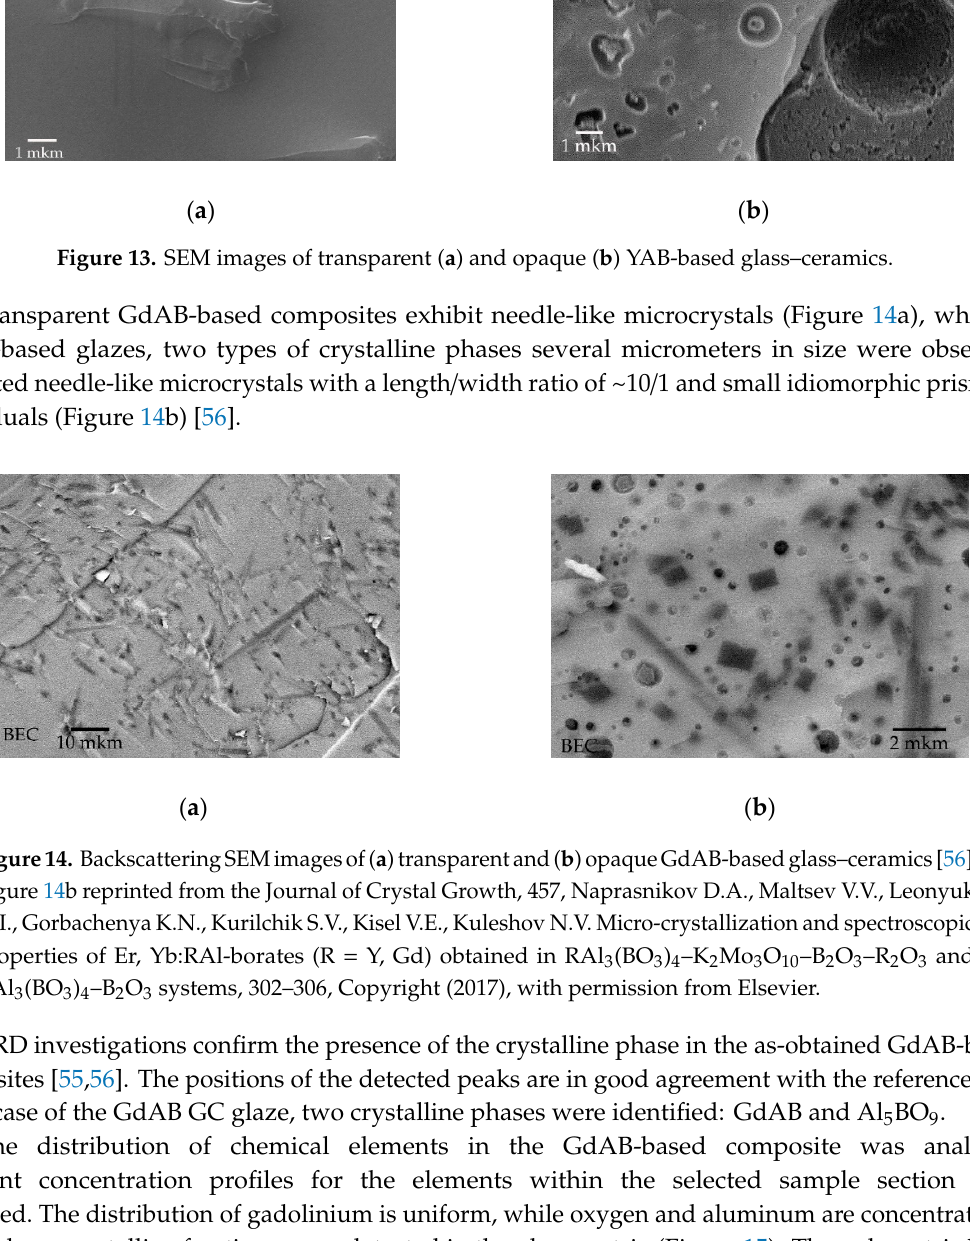
( c ) Figure 12. As-obtained ceramics: ( a ) transparent YAB-based glass–ceramic composites; ( b ) GdAB- containing glaze; ( c ) transparent GdAB-based glass–ceramic composites [56]. Figures 12a and 12b reprinted from the Journal of Crystal Growth, 457, Naprasnikov D.A., Maltsev V.V., Leonyuk N.I., Gorbachenya K.N., Kurilchik S.V., Kisel V.E., Kuleshov N.V. Micro-crystallization and spectroscopic properties of Er, Yb:RAl-borates (R = Y, Gd) obtained in RAl 3 (BO 3 ) 4 –K 2 Mo 3 O 10 –B 2 O 3 –R 2 O 3 and RAl 3 (BO 3 ) 4 –B 2 O 3 systems, 302–306, Copyright (2017), with permission from Elsevier.